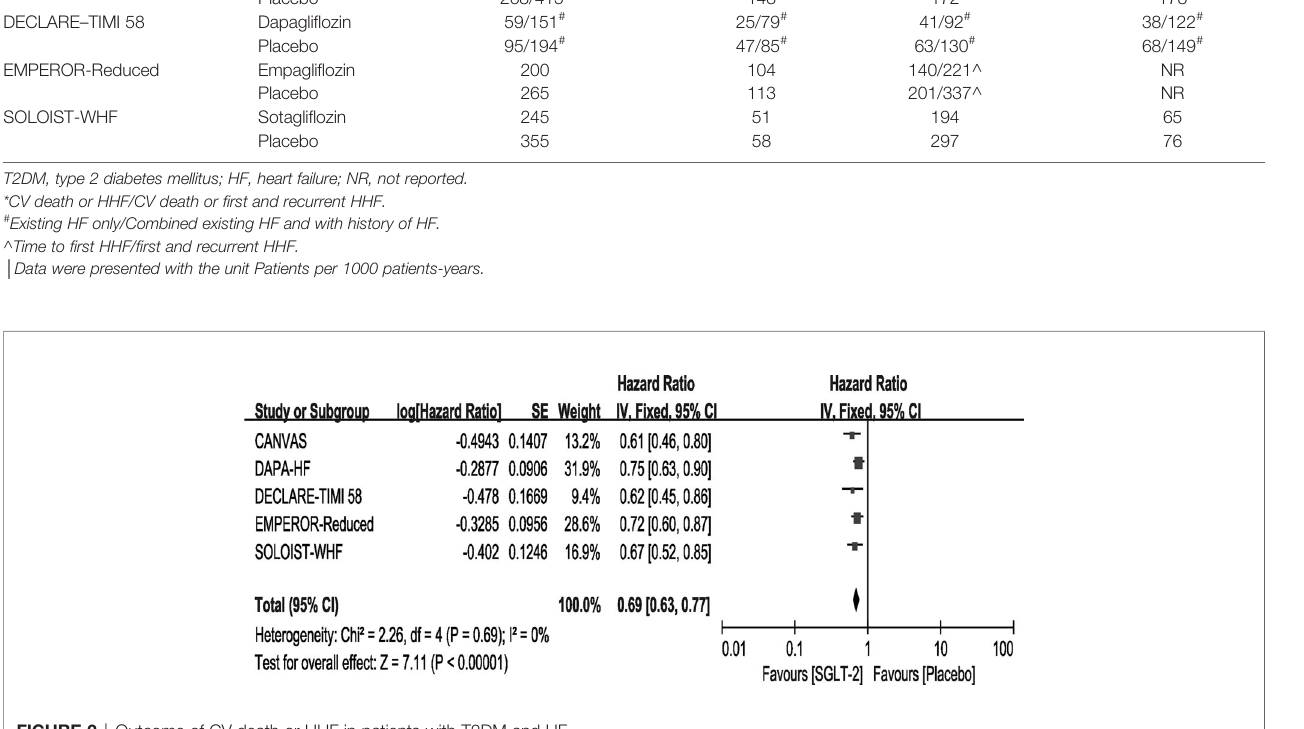
TABLE 3 | Outcomes of the subgroup analyses/main study comparing SGLT-2 inhibitors VS placebo in patients with T2DM and HF. Study Intervention CV death or HHF, n All caused mortality, n CANVAS │